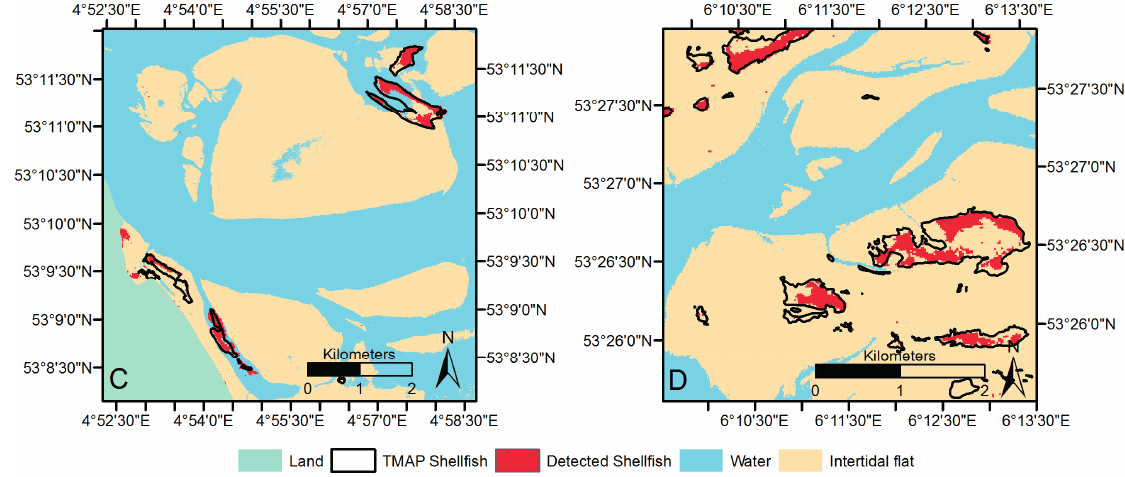
Figure 10. Details of the shellfish maps based on the TerraSAR-X classification for dual-polarization (brown) compared to the TMAP monitoring program